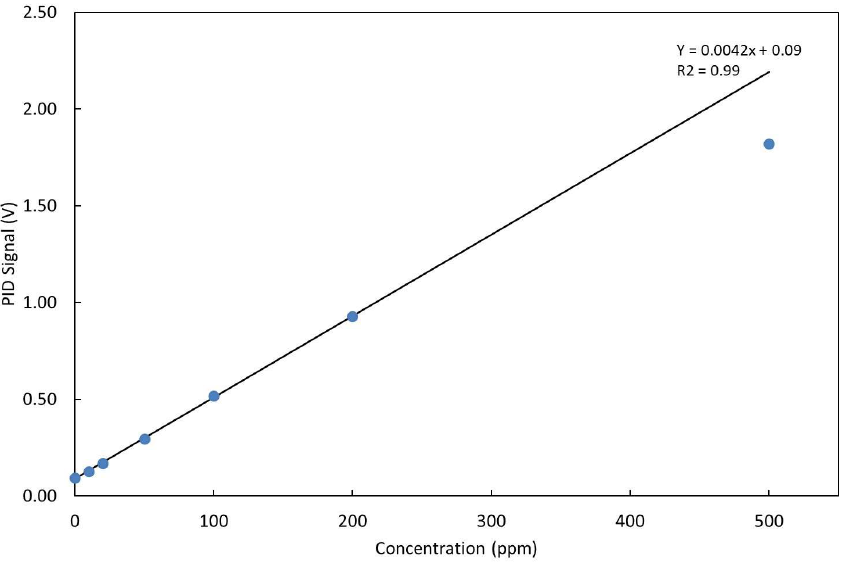
Figure 9. Response of the PID at different concentrations of NH 3 and linear fit of data up to 200 ppm.